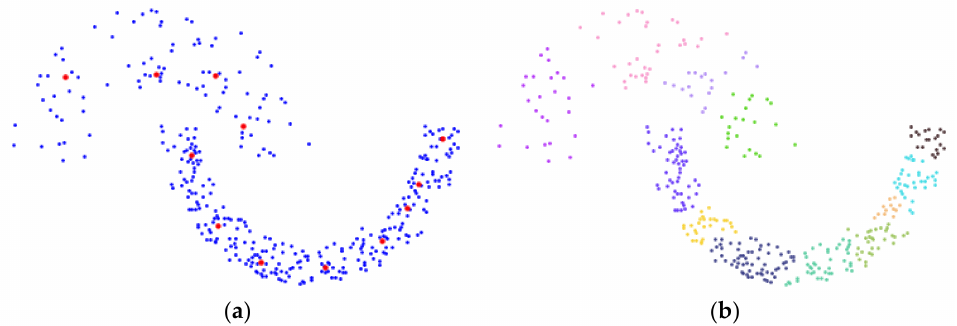
Figure 9. Detected preliminary clusters: ( a ) key point distribution in dataset; ( b ) cluster distribution of detected preliminary